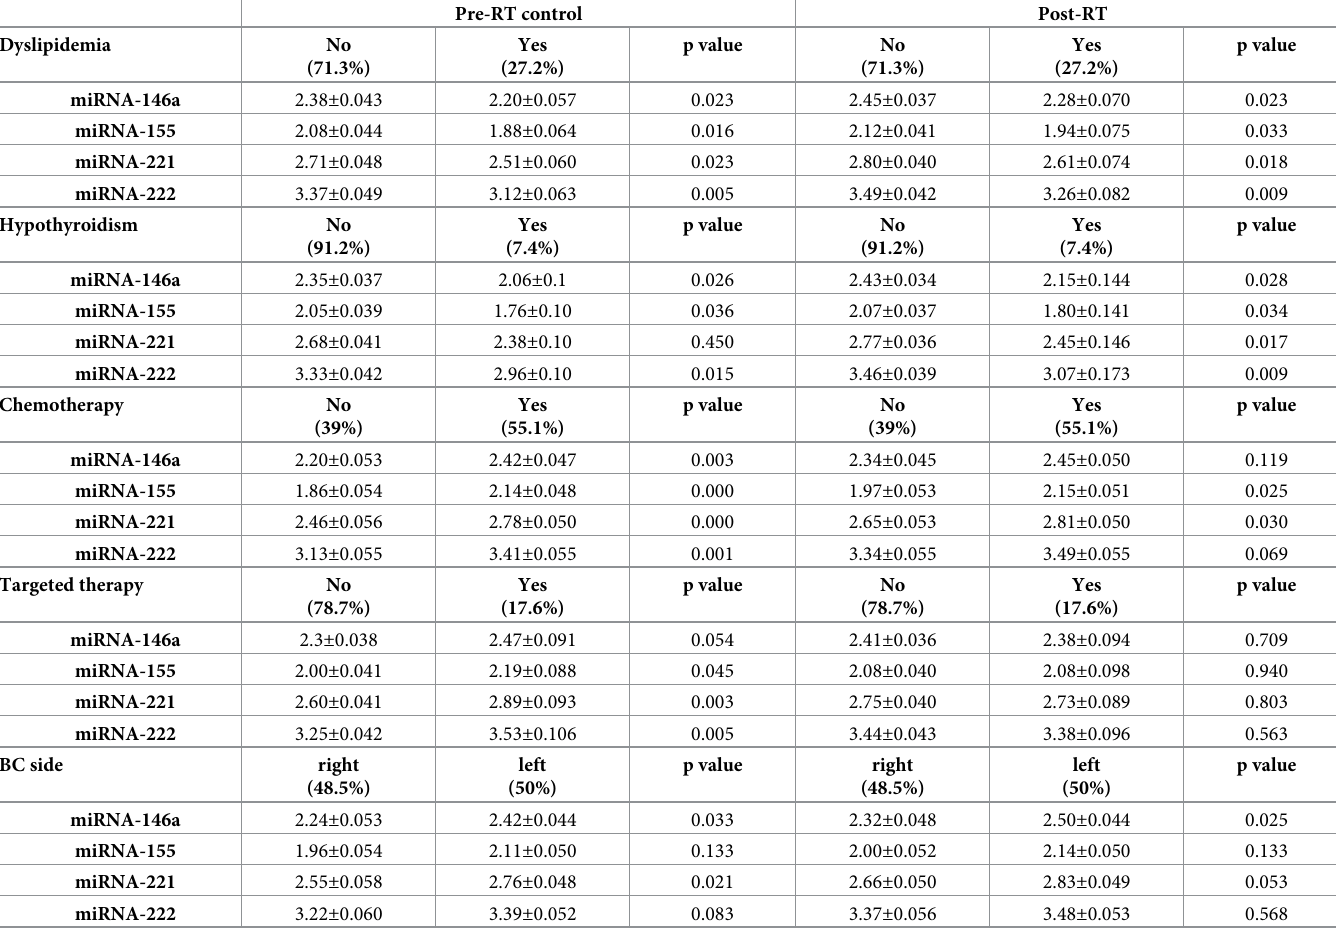
Table 3. Expression of selected miRNAs expression in blood of BC patients at pre-RT control and post-RT depending on CVD-linked clinical parameters, received treatment and BC side. Pre-RT